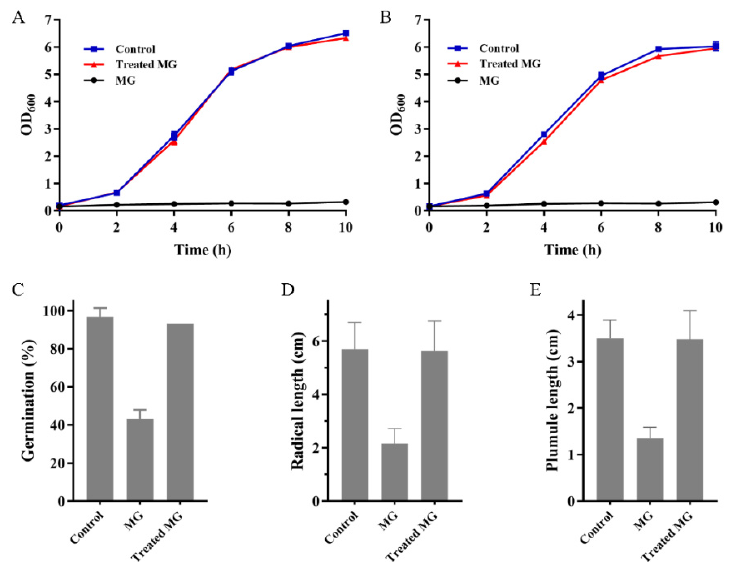
Figure 7. Toxicity evaluation of MG before and after Mut2 treatment. The growth curve of E. coli ( A ) and B. subtilis ( B ) in LB medium containing MG and treated MG. ( C ) The germination rate of Z. mays seeds in the solution of MG and treated MG. The radical length ( D ) and plumule length ( E ) of germinated Z. mays in the solution of MG and treated MG.